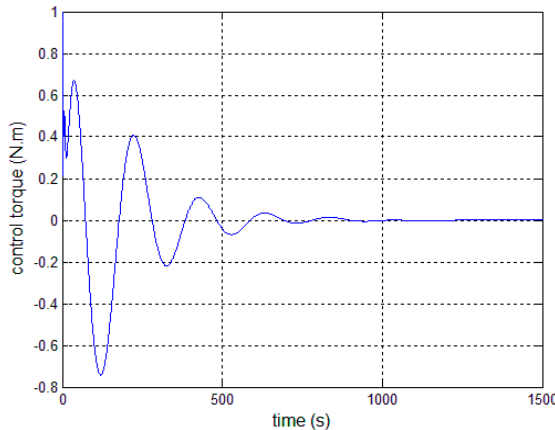
Figure 13. Control torque—controller, Equation (30).